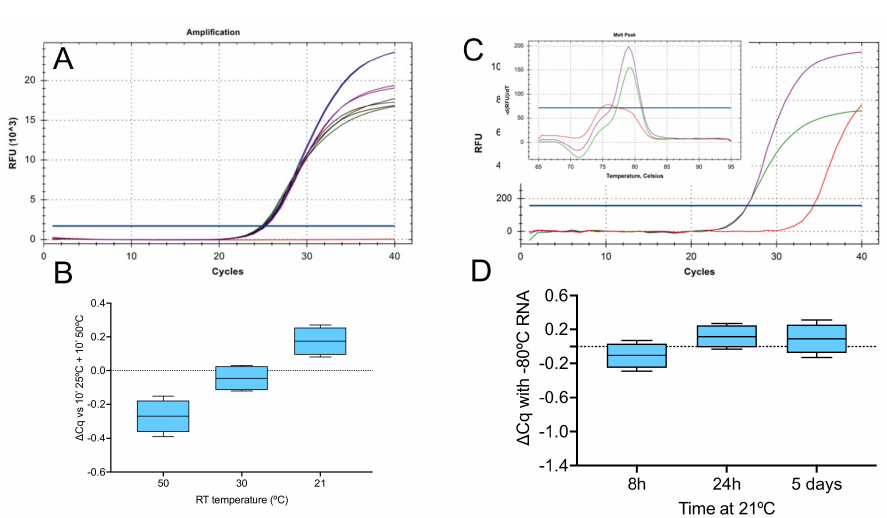
Figure 1. RT-qPCR of RNA reverse transcribed by SS4 and targeting the viral E-gene (assay E1). ( A ) Amplification plots and Cqs from duplicate qPCR reactions detected by a hydrolysis probe: conventional 10 min at 25 ◦ C and 50 ◦ C (blue), 5 min at 50 ◦ C (green), 30 ◦ C (brown) or 21 ◦ C (purple). ( B ) ∆ Cq for the three modified conditions relative to the conventional protocol. ( C ) Amplification plots and melt curves (inset) from single qPCR reactions: 5 min at 50 ◦ C (green) or 21 ◦ C (purple). The NTC is shown in red. ( D ) Cq values of RNA samples left on the bench for the indicated times relative to control sample kept frozen at − 80 ◦ C. Box and whiskers plots show the ∆ Cqs for the independent RT-qPCR reaction, with the whiskers delineating the minimum and maximum